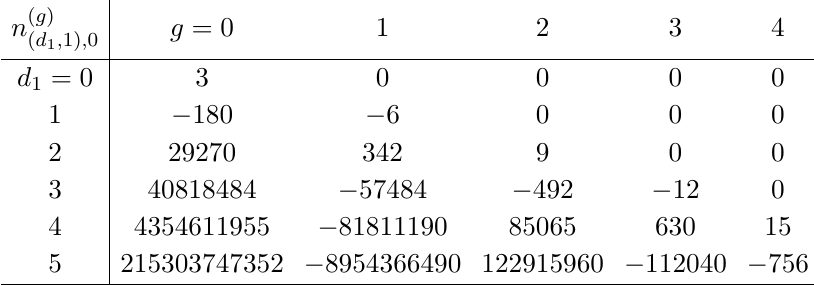
with Z charge 0 . 5 0